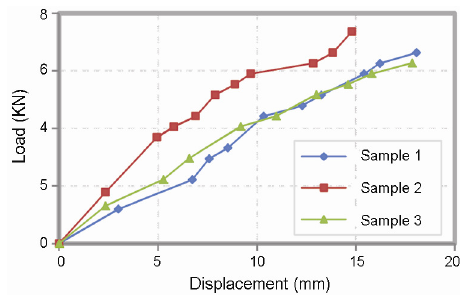
Fig. 9. Load-displacement curves for different specimens strengthened with one layer of GFRP and with surface preparation